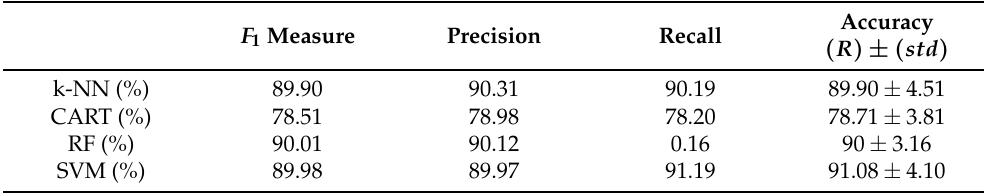
Table 2. F 1 -measure per class, F 1 -measure, precision, recall and average of accuracy rates ( R ) and its standard deviation ( std ) for each model